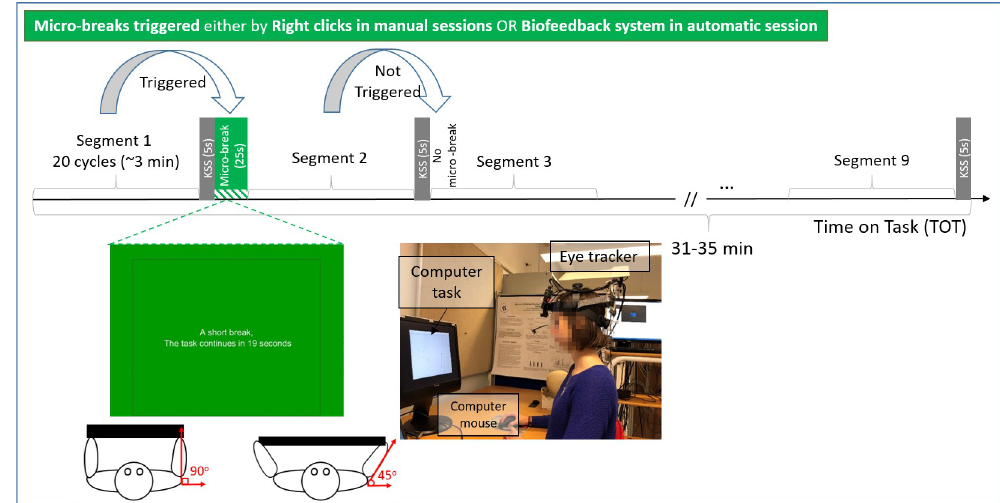
Fig 1. The task timeline in the manual and automatic sessions (see micro-breaks). A schematic view of the exercise and screen information during a micro-break, and the experiment set-up. [The individual in this manuscript has given written informed consent (as outlined in PLOS consent form) to publish these case